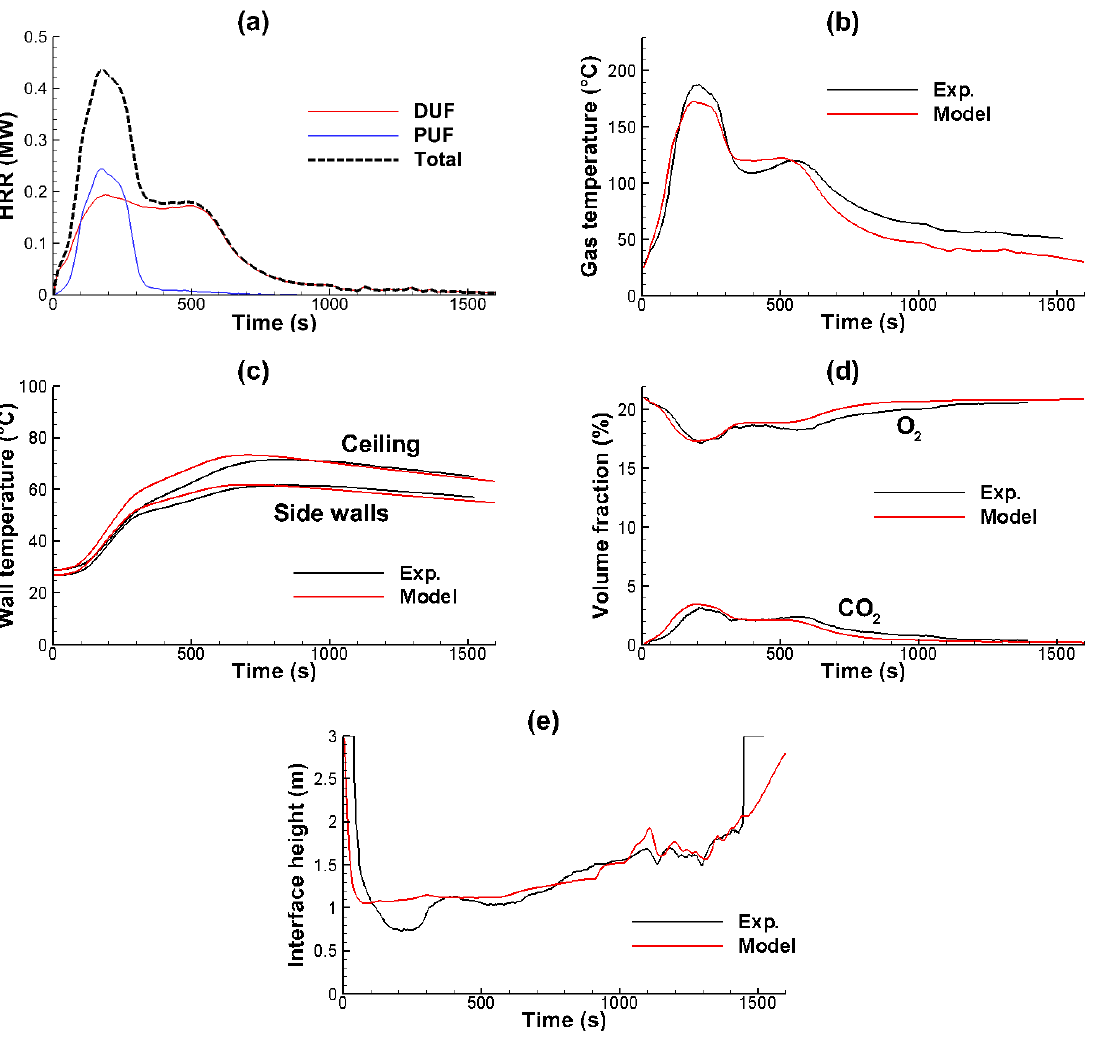
Figure 14. Test 6: ( a ) individual and total HRRs, ( b ) average gas temperature, ( c ) average wall temperatures, ( d ) volume fractions of O 2 and CO 2 in the exhausted gases, and ( e ) smoke layer interface